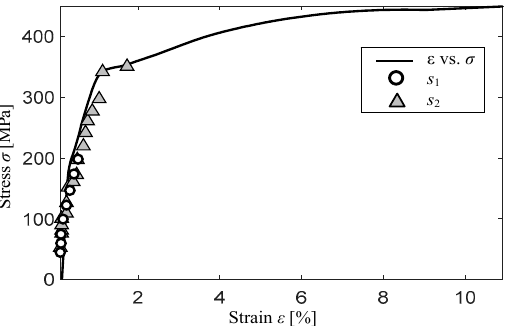
Figure 3. View of the sample shape with dimensions in [mm]: 2D model and photo. The samples’ thickness is 2 mm.